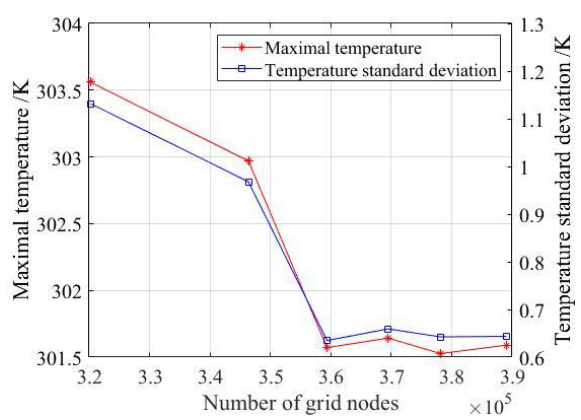
Figure 4. Grid independence test based on the maximum temperature (MaxT) and temperature standard deviation (TSD).